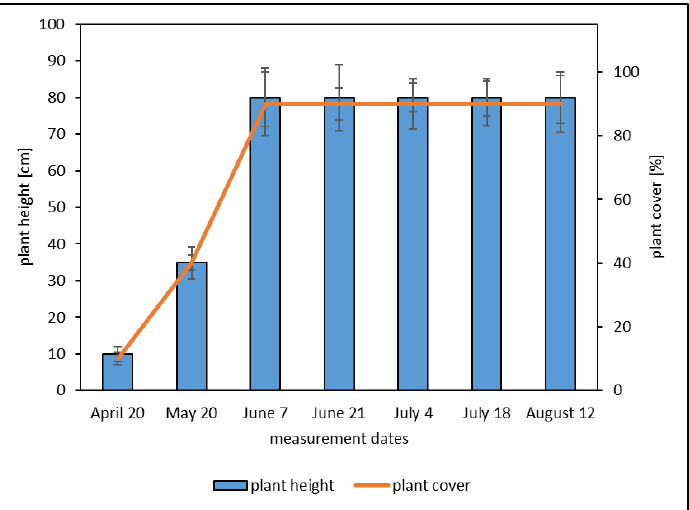
Figure 2. Vegetation development in the wheat field.